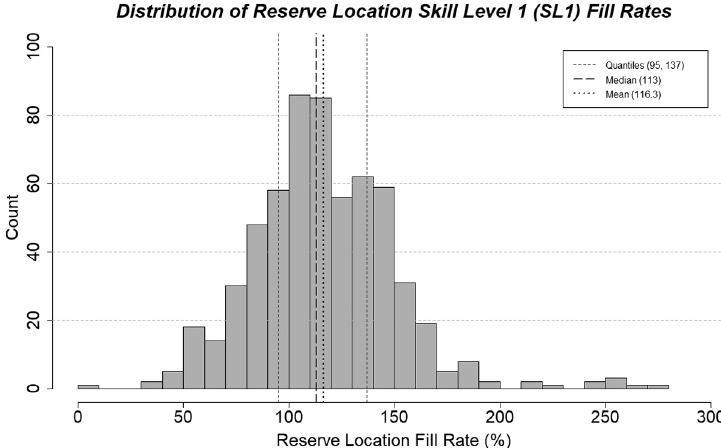
Figure 1. Distribution of reserve location skill level (SL1) fi ll